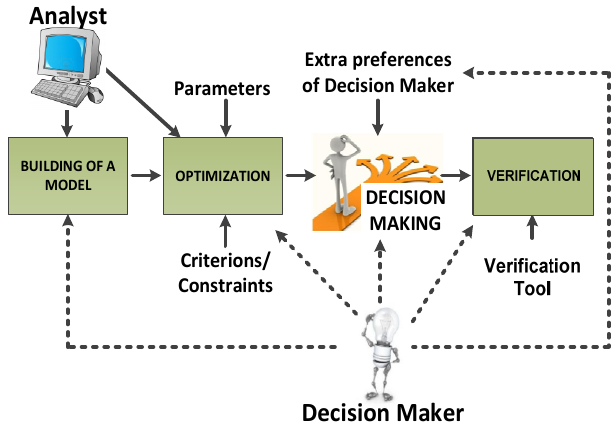
Fig. 2. Basic elements and steps of the optimization process.